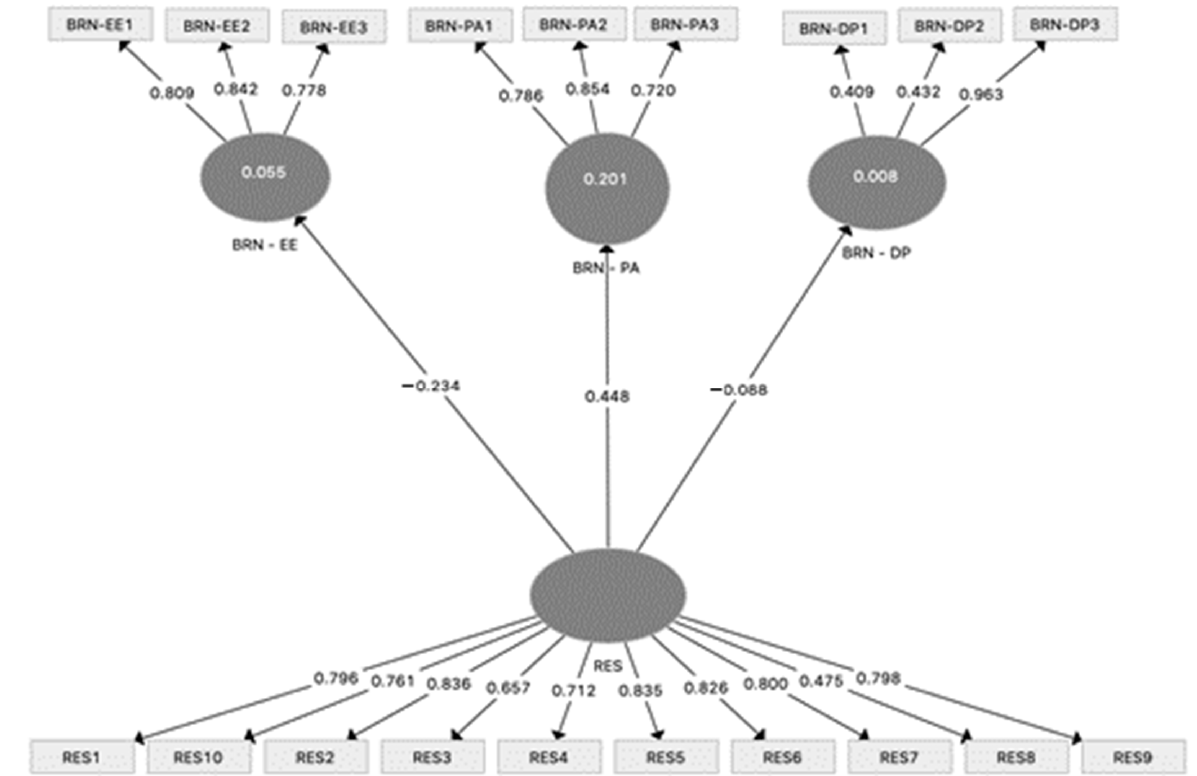
Figure 2. PLS model. After obtaining the PLS model, it lacks validation in terms of predictive precision, reliability, and discriminant validity (Table 2). The predictive precision of the model is evaluated through the R2 that appear in the circles of the latent variables. According to Cohen (1988), the R2 of the variables BRN-EE (0.055) and BRN-DP (0.08) have a “small” effect and the variable BRN-PA (0.201) has a “medium” effect. The model’s reliability is evaluated through three indicators: Cronbach’s Alpha, composite reliability, and Average Variance Extracted (AVE). The first two indicators have 0.70 as reference values and the AVE 0.50, according to Hair et al. (2019). As shown in Table 3, the company presents internal convergence and is “satisfactory to good”, presenting values for the three indicators higher than the reference ones. Finally, the estimated PLS model has discriminant validity, which is evaluated by the Fornell–Larcker criterion, since the average variance extracted from the latent variable found on the diagonal marked in Table 2 is higher than the square correlations with the other variables